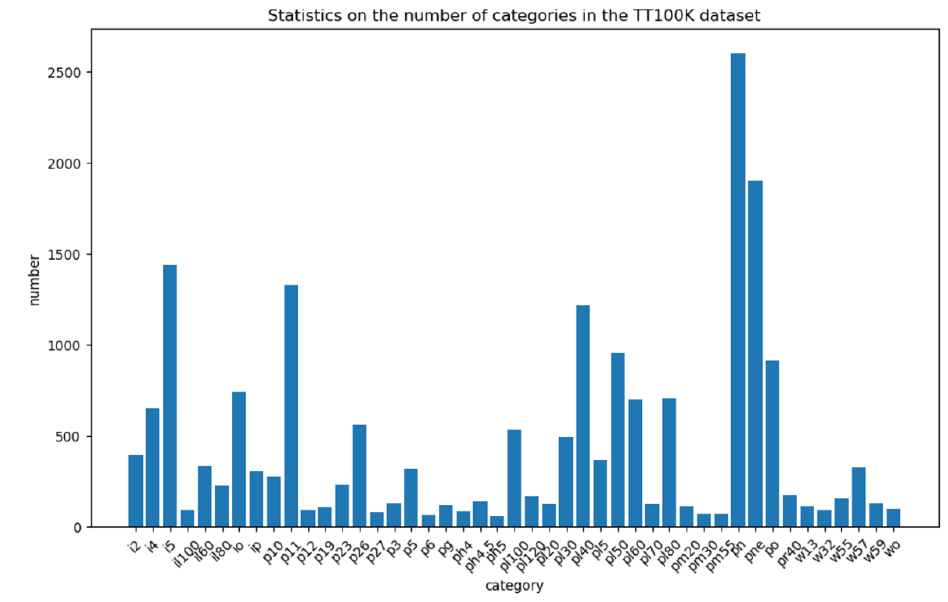
Figure 9. TT100K-45 comparison of the number of each traffic sign category.